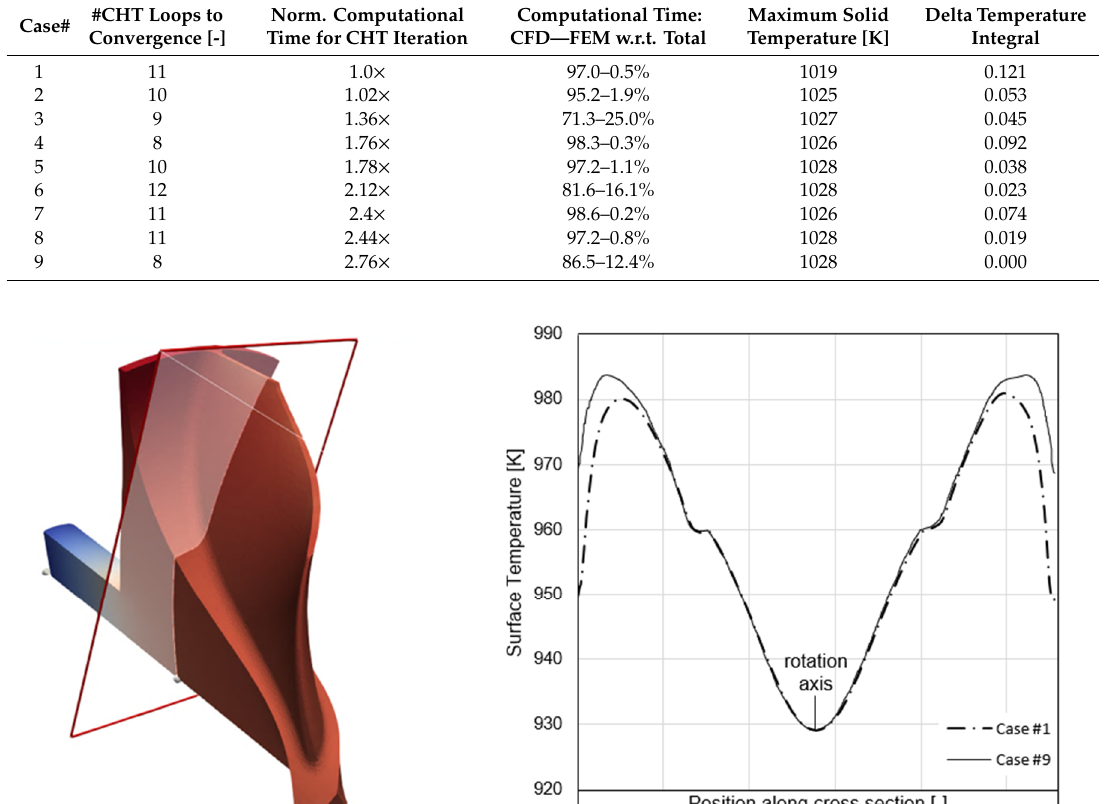
Table 5. Fluid–solid grid sensitivity: summary of CHT computations.